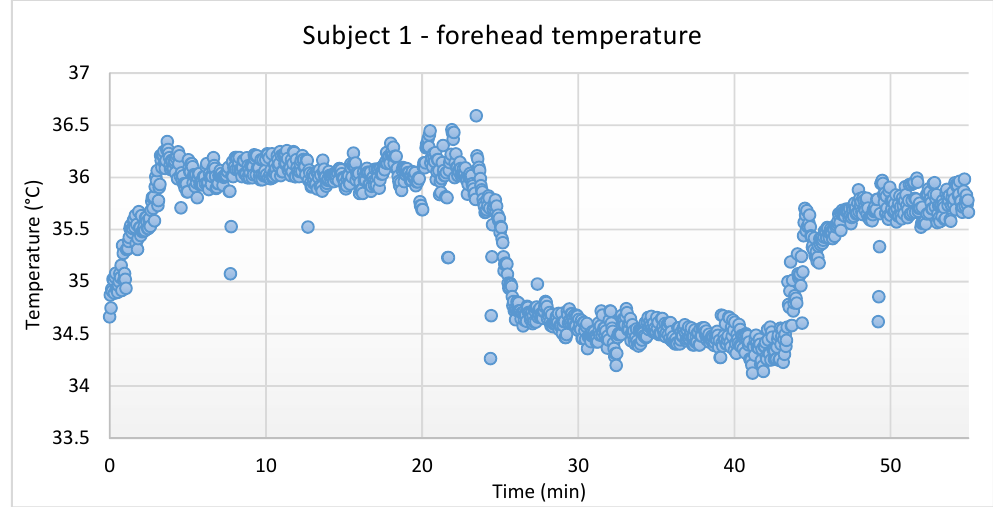
Figure 5. An example of the forehead temperature readings of one of the subjects.